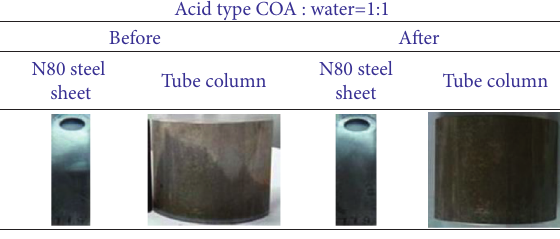
Figure 1: Pictures before and after corrosion tests of steel